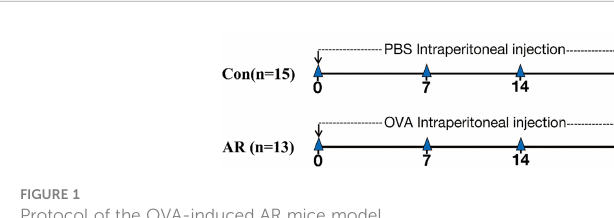
FIGURE 1 Protocol of the OVA-induced AR mice